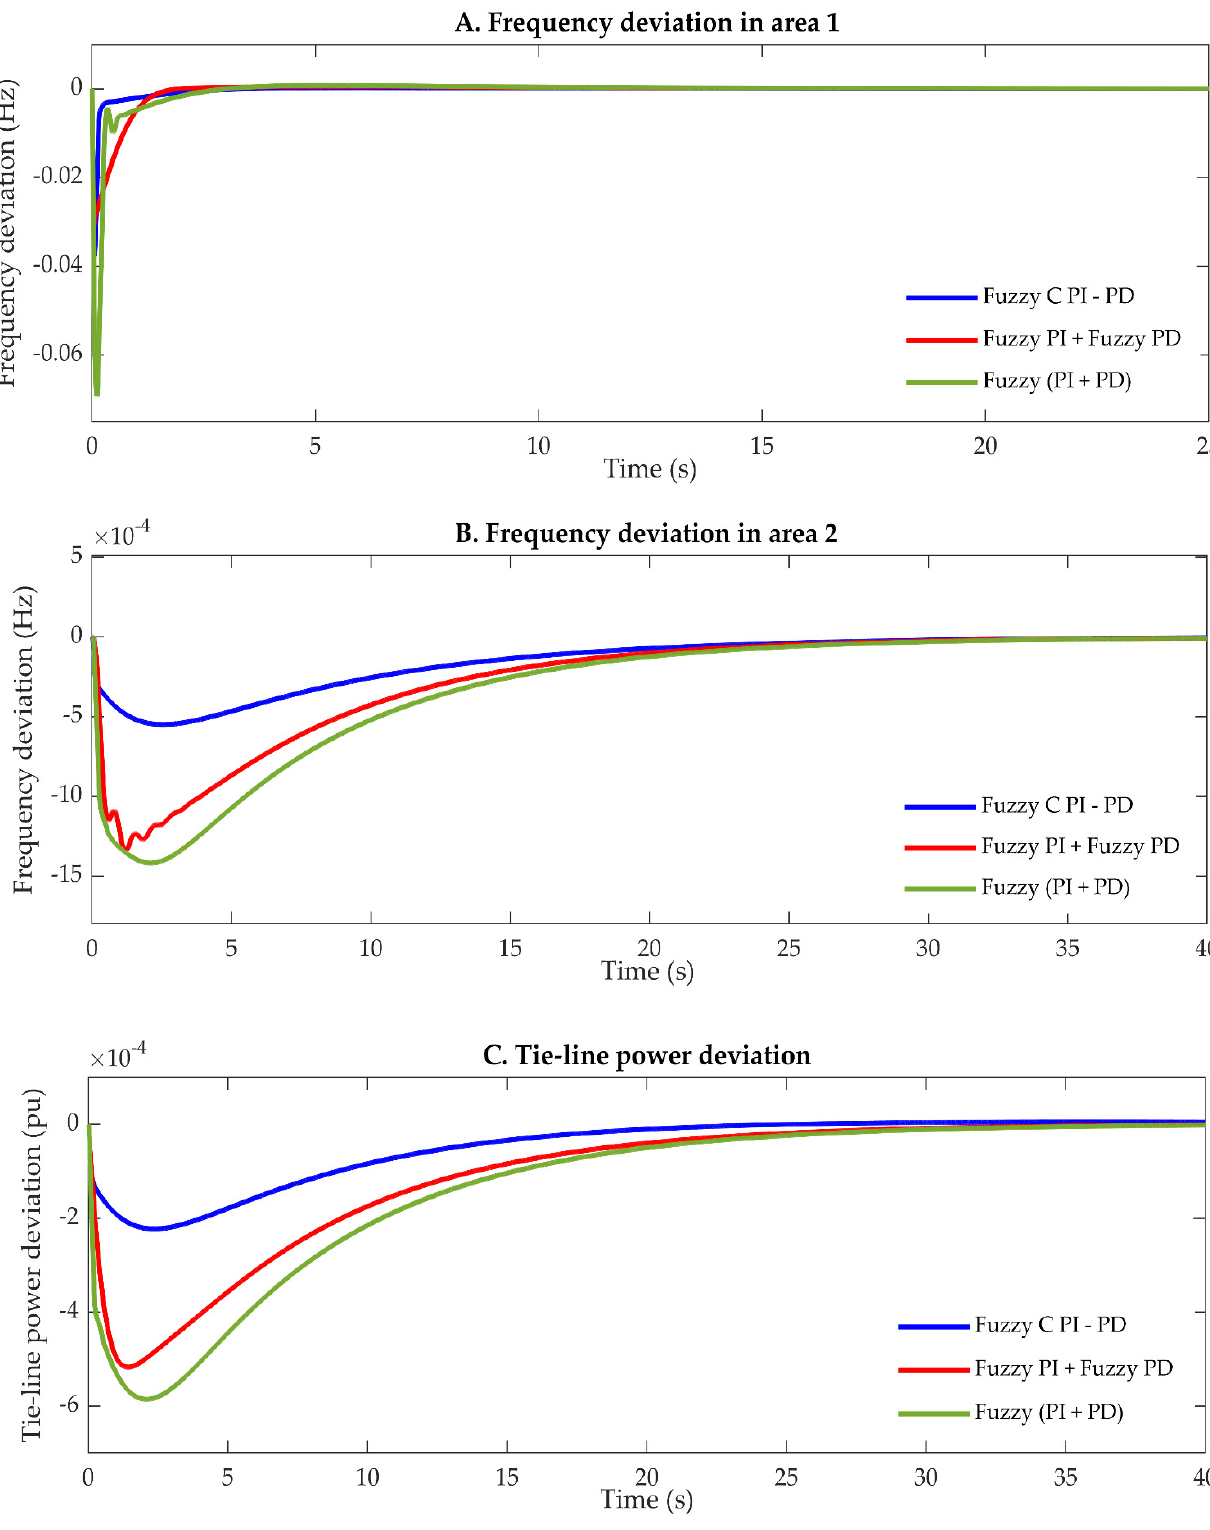
Figure 26. Dynamic response of the testbed power system based on different fuzzy controllers under parametric uncertainty conditions, case 5. ( A ) Frequency variation in area 1; ( B ) frequency variation in area 2; ( C ) tie-line power variation.